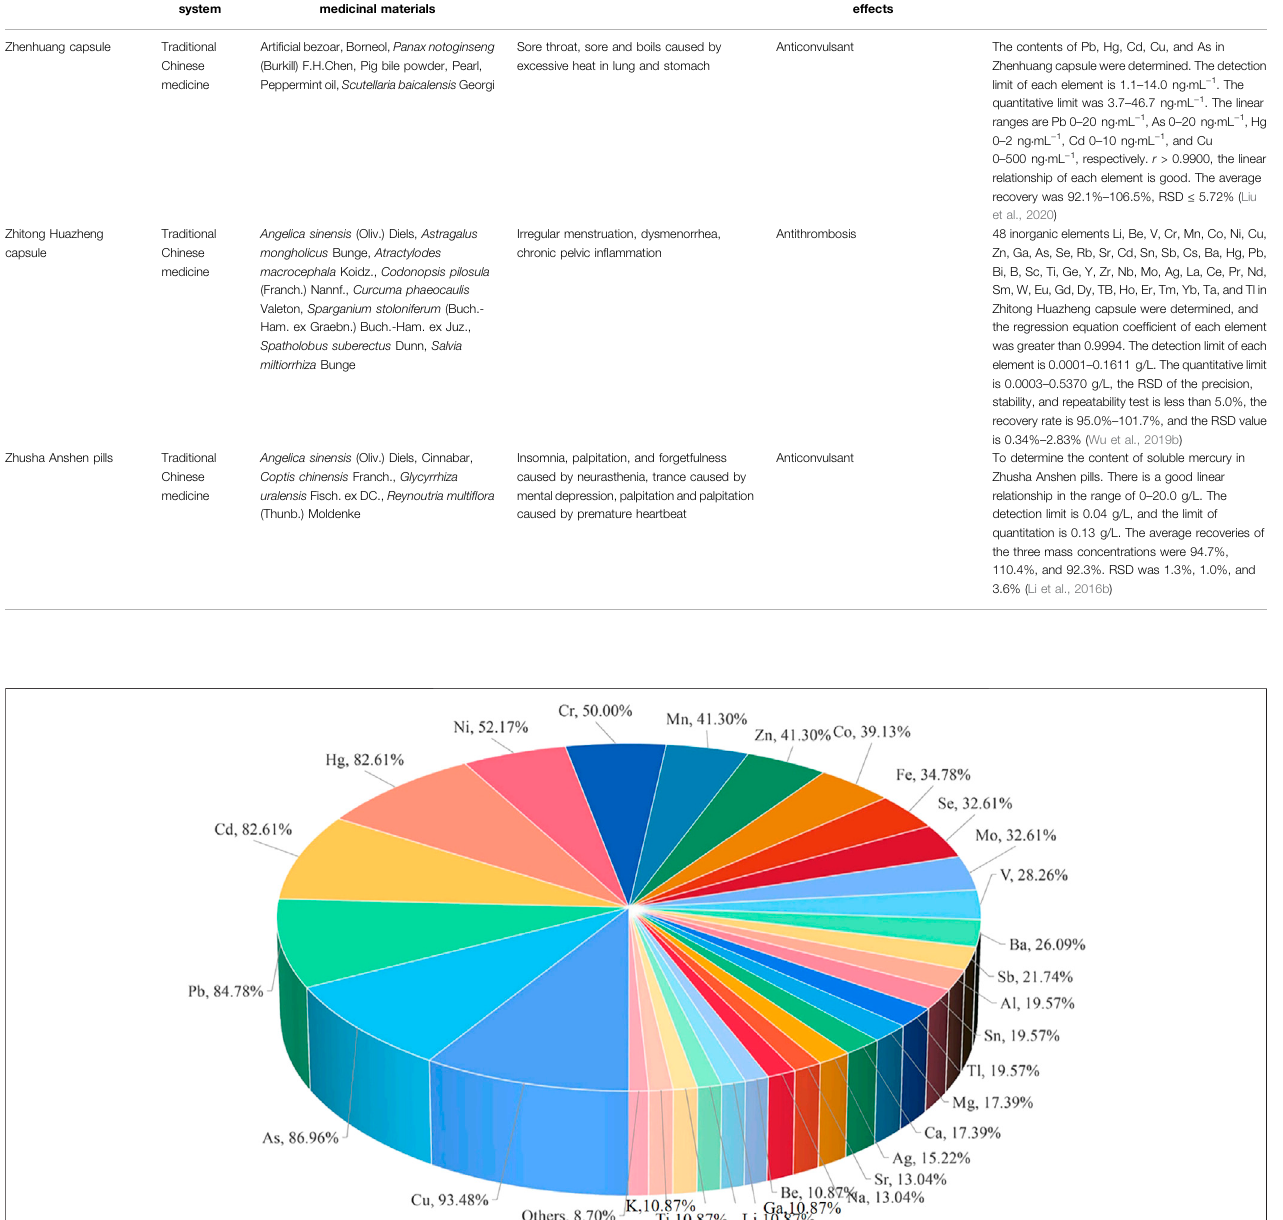
Frontiers in Pharmacology |